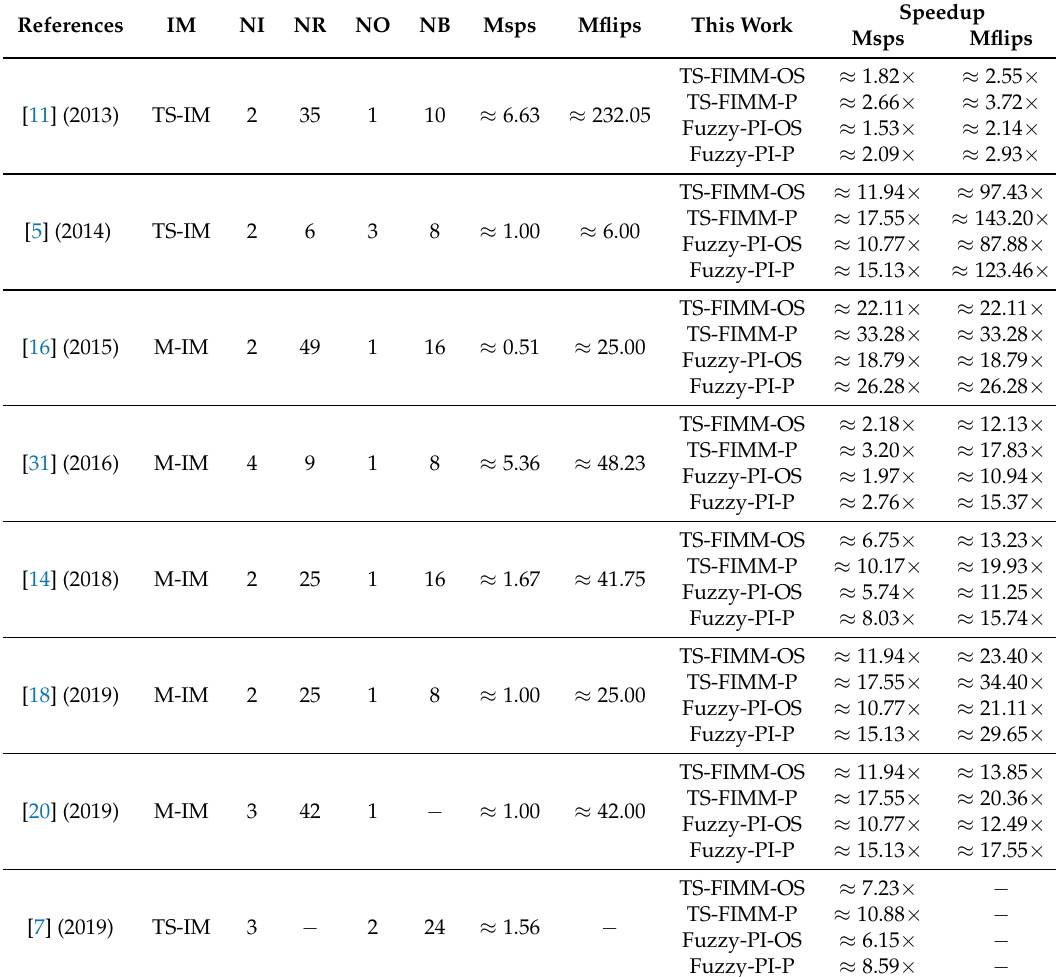
Table 7. Throughput comparison with other